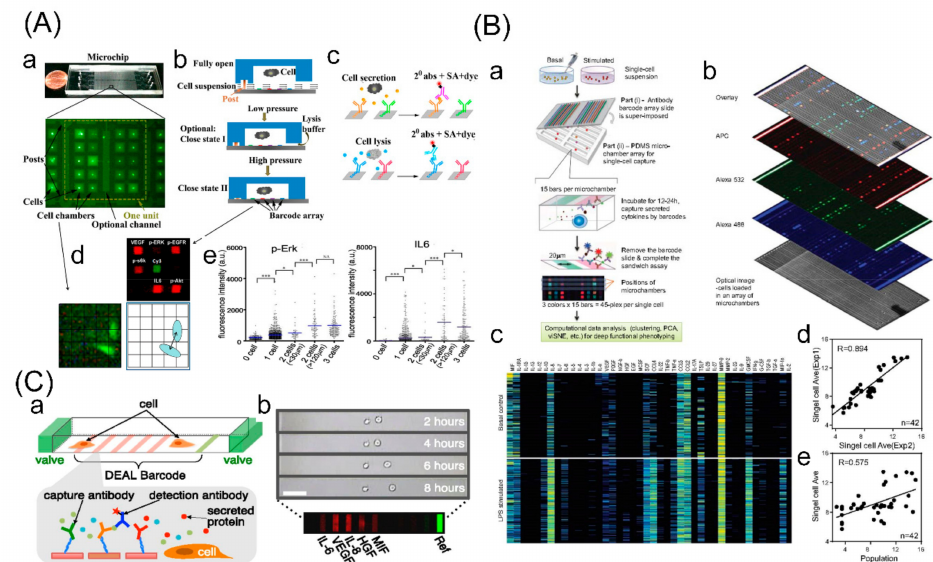
Figure 5. Microchamber-based assay (barcoding microchips) for single-cell protein analysis. ( A ) A single-cell barcode chip for quantitative measurements of membrane, intracellular, and secreted proteins from single cells. (a) Image of the microchip and a fluorescence micrograph of a cellular assay unit (20 microchambers); (b) workflow of the on-chip operation. Fully open: cells are loaded into the microchambers. Close-I state: microchambers are sealed by a low pressure on the microchip but lysis bu ff er can be introduced to the channel. Close-II state: cells are isolated completely in the microchambers from the channel by a high pressure; (c) workflow of detecting of membrane, intracellular, and secreted protein via the sandwich-type fluorescence immunoassay; (d) single-cell proteomic result of fluorescence intensity, cell numbers and cell positions; (e) fluorescence data for secreted and intracellular protein assays. Adapted with permission from [93]. ( B ) A microchamber-based platform combined with spatial and spectral encoding. (a) Workflow illustration of high-throughput profiling of single cells in basal and stimulated conditions for 42 secreted e ff ector proteins; (b) representative optical image showing a block of microchambers loaded with U937-derived macrophage cells and the corresponding scanned fluorescence images showing protein detections with three colors; (c) representative heat maps showing single-cell protein profiles measured on U937-derived macrophages; (d) correlation of protein secretion expressions between two replicate microchip experiments at single-cell levels, and (e) between single-cell levels measured using microchips and population levels measured using conventional methods. Adapted with permission from [94]. ( C ) A barcoding microchip for identifying most stable separation distance between two cells. (a) Schematic of a single microchamber with valves and barcodes (top) and the fluorescent sandwich immunoassay protein detection scheme (bottom); (b) a representative time-lapse image of a two-cell chamber over 8 h and a typical fluorescence image of a barcode for the five assayed proteins. Adapted with permission from